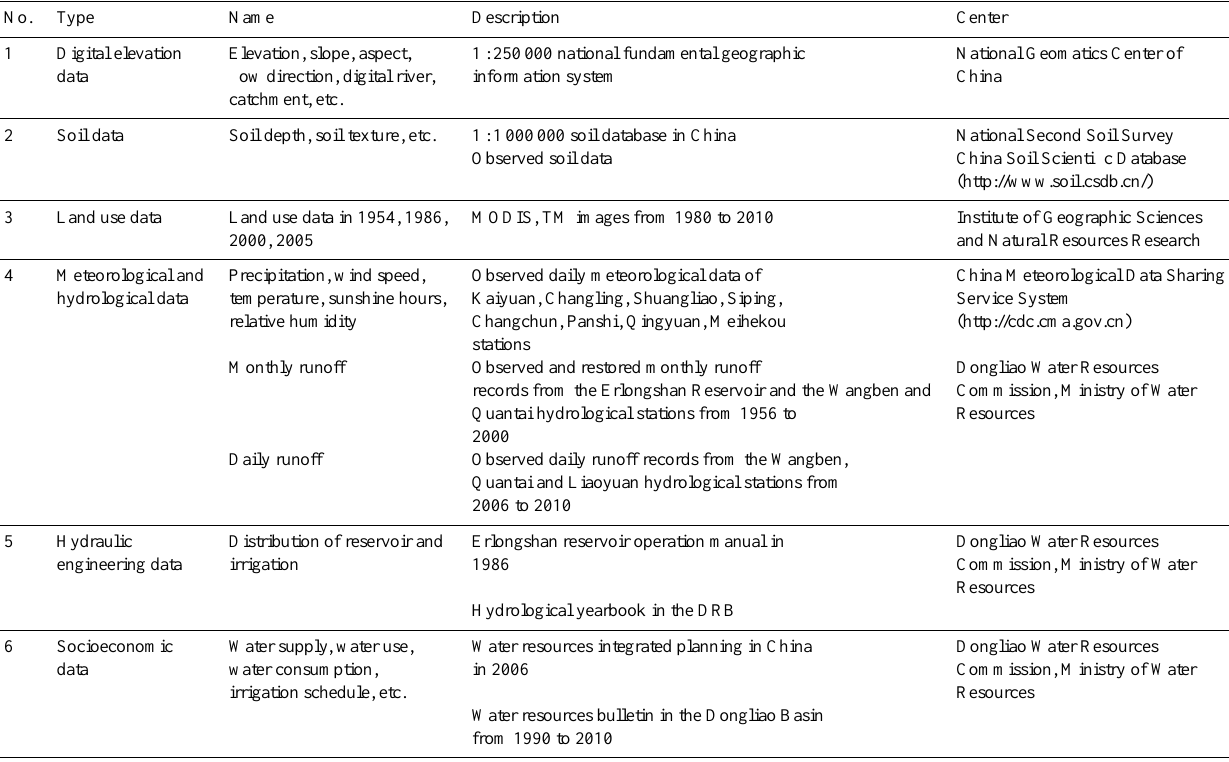
Table 2. Model input data and their source.